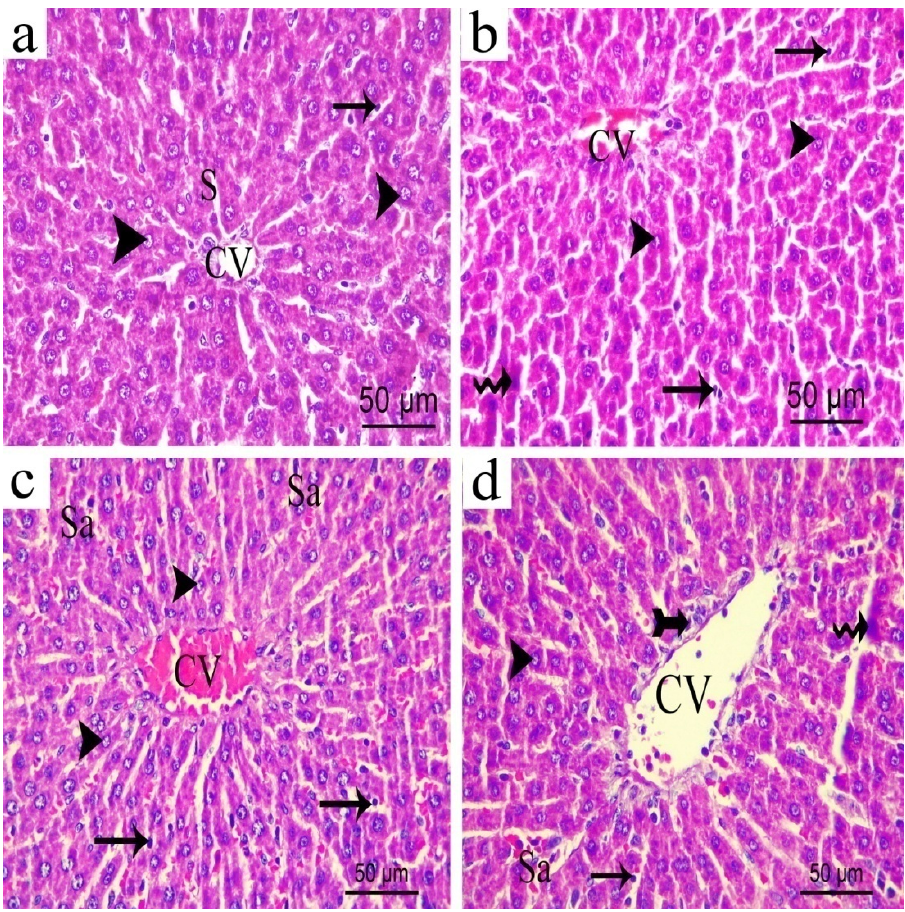
Figure 19. Representative photograph of liver sections from: ( a ) normal; ( b ) CCI; ( c ) H. campechianum flower extract (p.o., 200 mg/kg); ( d ) H. campechianum flower extract (p.o., 400 mg/kg). Head arrow, arrow, wavy arrow and bifid arrow illustrate normal hepatocytes, Kupffer cell, hepatocytes with dark stained nuclei and cellular infiltrations, respectively. CV, the central vein; S, normal blood sinusoids; sa, dilated or congested sinusoids. Scale bar, 50 μm × 400.